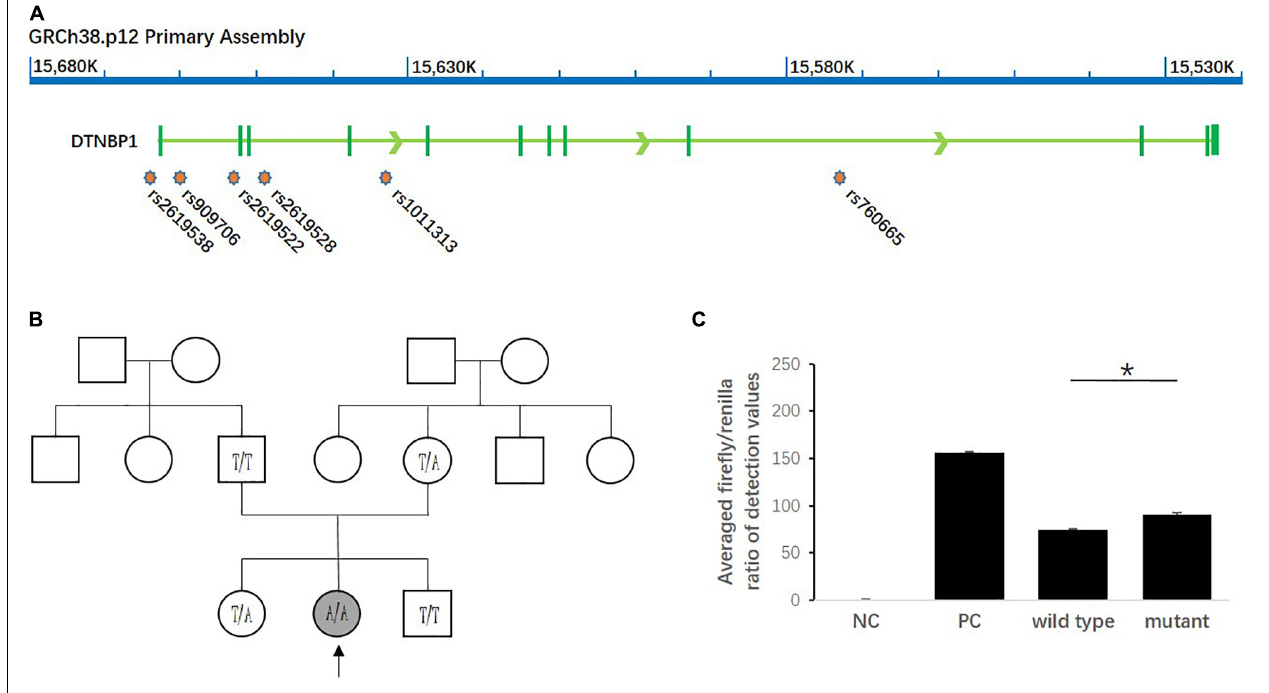
FIGURE 2 | Impact of the homozygous mutation of rs2619538 T > A on DTNBP1 transcription. (A) Relative loci of rs2619538 T > A and other SNPs genotyped in this study are shown in the DNTBP1 gene region. Only rs2619538 T > A is potentially functional because of its location in the predicted promoter of the DNTBP1 gene, and yet the remaining SNPs are located within several introns of the DTNBP1 gene. (B) The TLE patient carrying the homozygous mutation of rs2619538 T > A was a 33-years-old male (age at onset, 32 years). After observation of the treatment for 1 year, seizure frequencies decreased from three times per month to one time per half year. A genealogical chart of his family was also constructed, and his parents consented to genotyping of the same site at rs2619538 T > A; a novo mutant allele probably coming from his father was observed. (C) The effects of rs2619538 T > A mutant on the activity of the DTNBP1 gene promoter. Compared with the averaged firefly/renilla ratios of the pGL3 basic negative control (NC), the ratios of the pGL3 promoter positive control (PC), pDTNBP1-Promoter-Wildtype (Wildtype) and pDTNBP1-Promoter-Mutant (Mutant) for rs2619538 T > A were 155.74 ± 1.43, 74.07 ± 0.99, and 90.48 ± 2.09, respectively. * p <